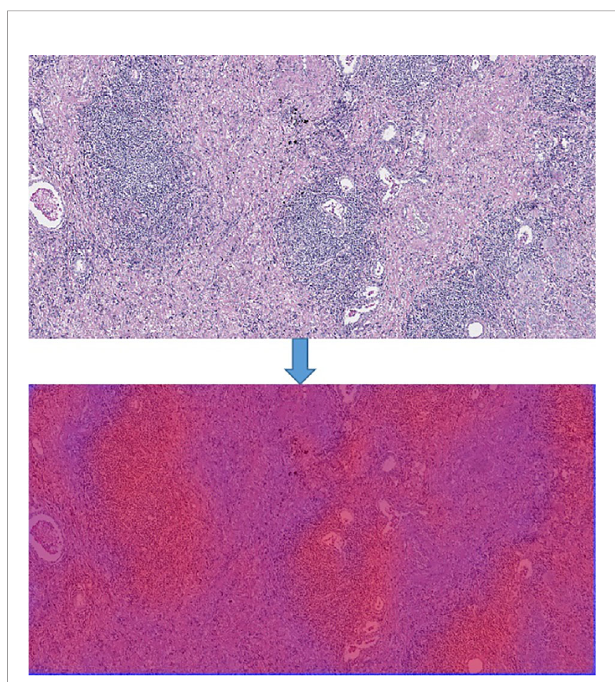
FIGURE 4 | Heatmap of the tumor region applied in the CNN model by using TCGA dataset. The above image is the original image, the under image is the heat map.